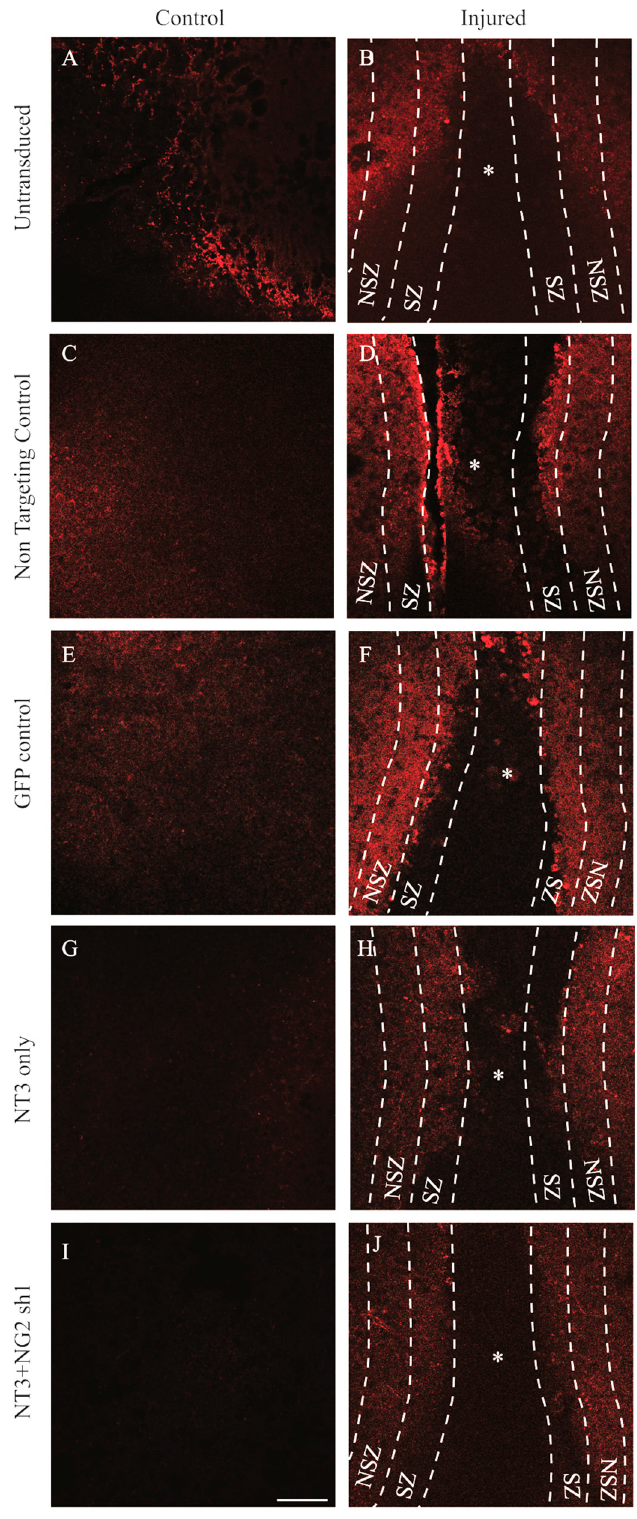
Figure 7. Confocal images showing NG2 levels in untransduced and lentiviral vector transduced control and transection injured ex vivo spinal cord slices. Photomicrographs show projected confocal images of NG2 (red) in untransduced ( A , B ), non-targeting control ( C , D ), Lenti GFP transduced ( E , F ), Lenti-NT-3-transduced ( G , H ) and Lenti-NT-3 / NG2 sh1 transduced ( I , J ) control and injured slices, respectively. * = injury zone (IZ); dashed lines separate the regions of interest examined: scar zone (SZ) and near scar zone (NSZ). SZ and NSZ were 100 µm in width. Scale bar = 100 µm.